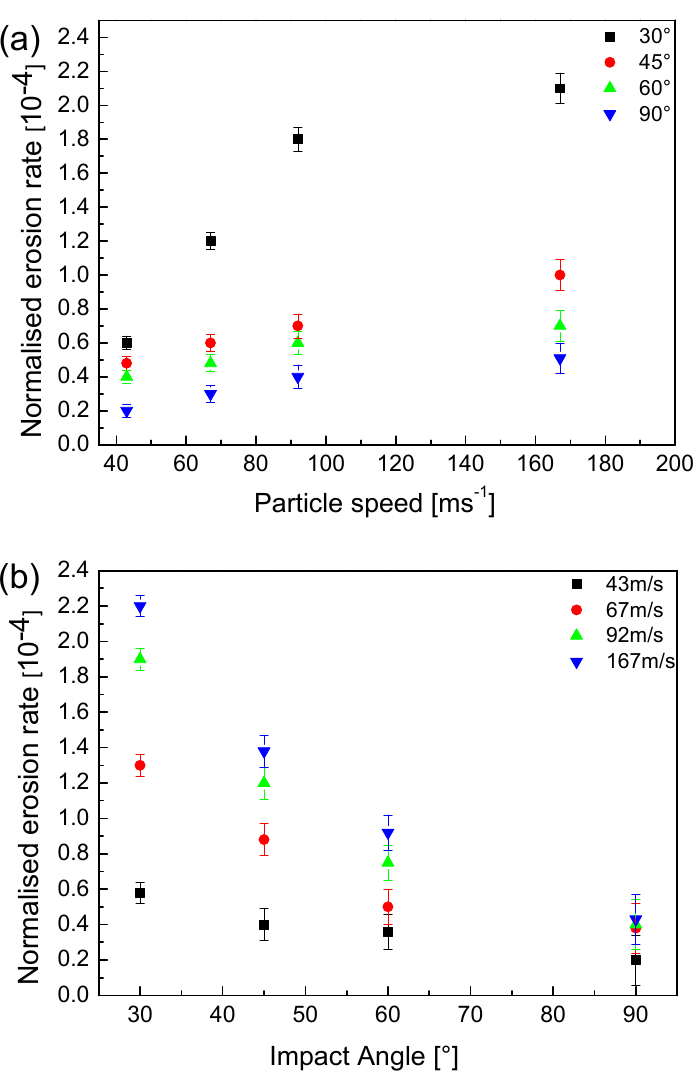
Figure 5. Normalized erosion rate vs. ( a ) particle speed and ( b ) impact angle. Error bars indicates 1 sigma scatter.